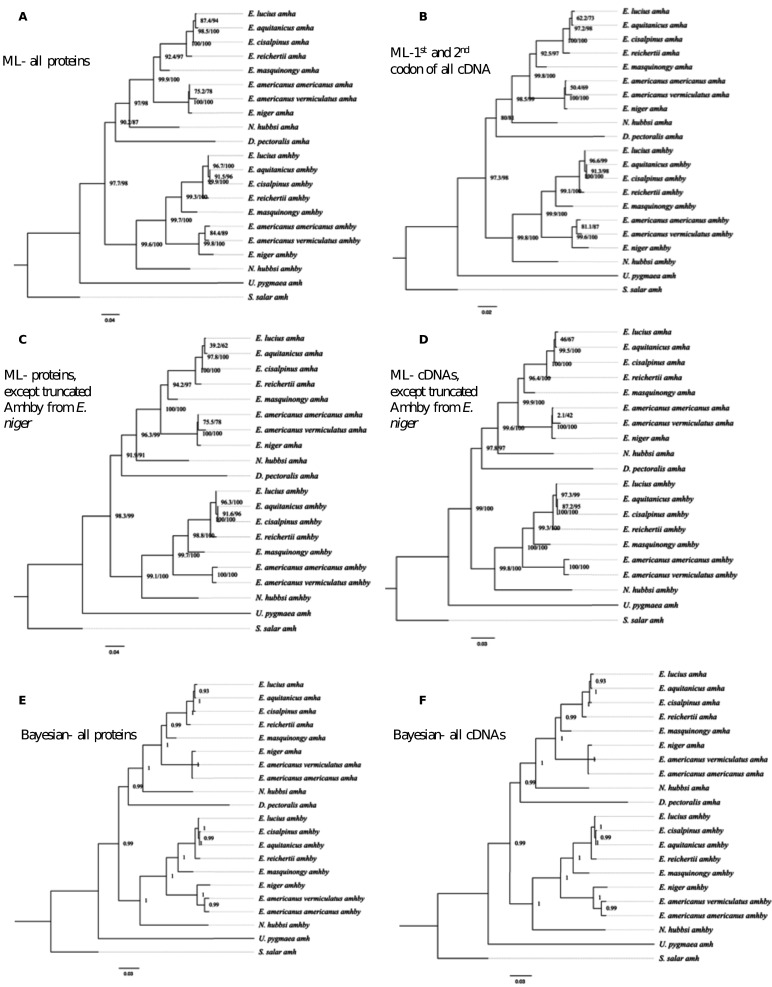
Additional phylogenetic reconstruction of amha and amhby orthologs from the Esociformes with amh sequence from Salmo salar as an outgroup.(A) Phylogenetic tree built by Maximum likelihood method implemented in IQ-TREE putative protein sequences of all identified amh homologs. (B) Phylogenetic tree built by Maximum likelihood method with only the 1st and 2nd codon of putative coding sequence of all identified amh homologs. (C) Phylogenetic tree built by Maximum likelihood with putative protein sequences of amh homologs without one highly truncated sequence from E. niger. (D) Phylogenetic trees built by Maximum likelihood with putative coding sequences of amh homologs without one highly truncated sequence from E. niger. (E) Phylogenetic tree built by Bayesian method implemented in PhyloBayes with putative protein sequences of all identified amh homologs. (F) Phylogenetic tree built by Bayesian method with putative coding sequences of all identified amh homologs. Bootstrap values are given on each nod of the tree and all trees are rooted with amh sequence from S. salar.